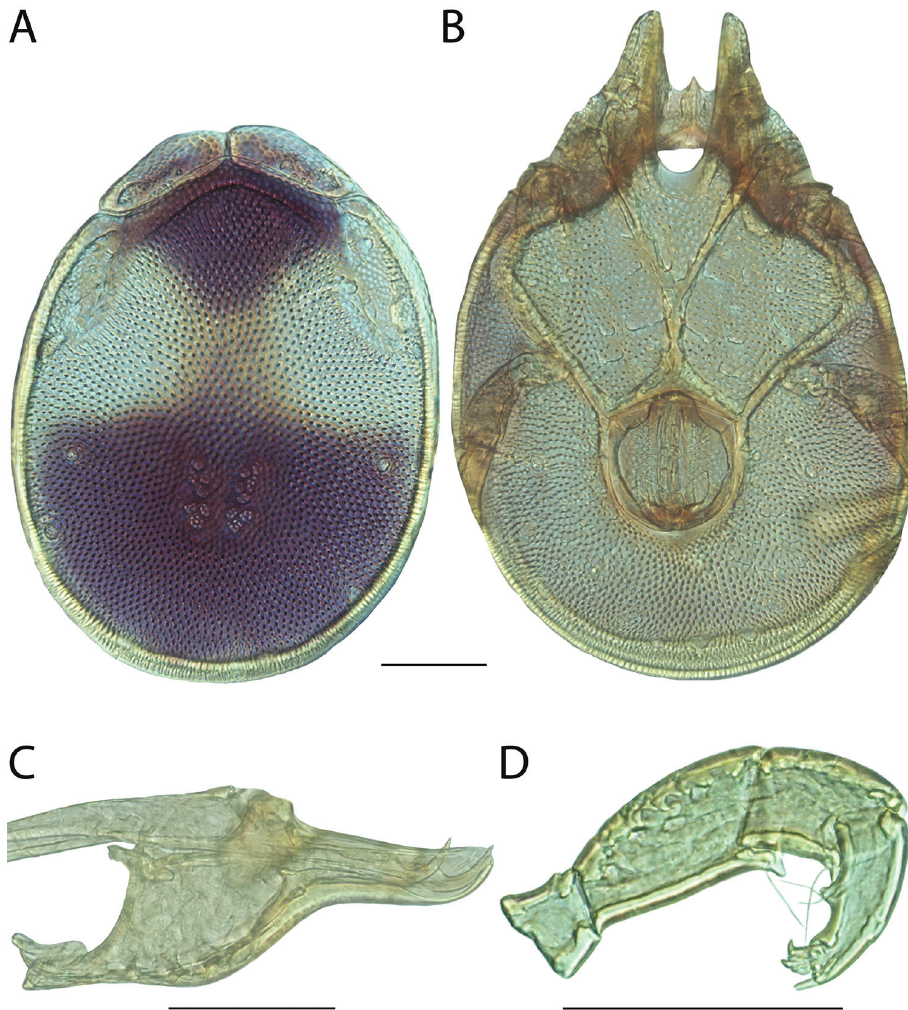
Figure 189. Torrenticola pendula sp. n. male: A dorsal plates B venter (legs removed) C subcapitulum D pedipalp (setae not accurately depicted). Scale = 100